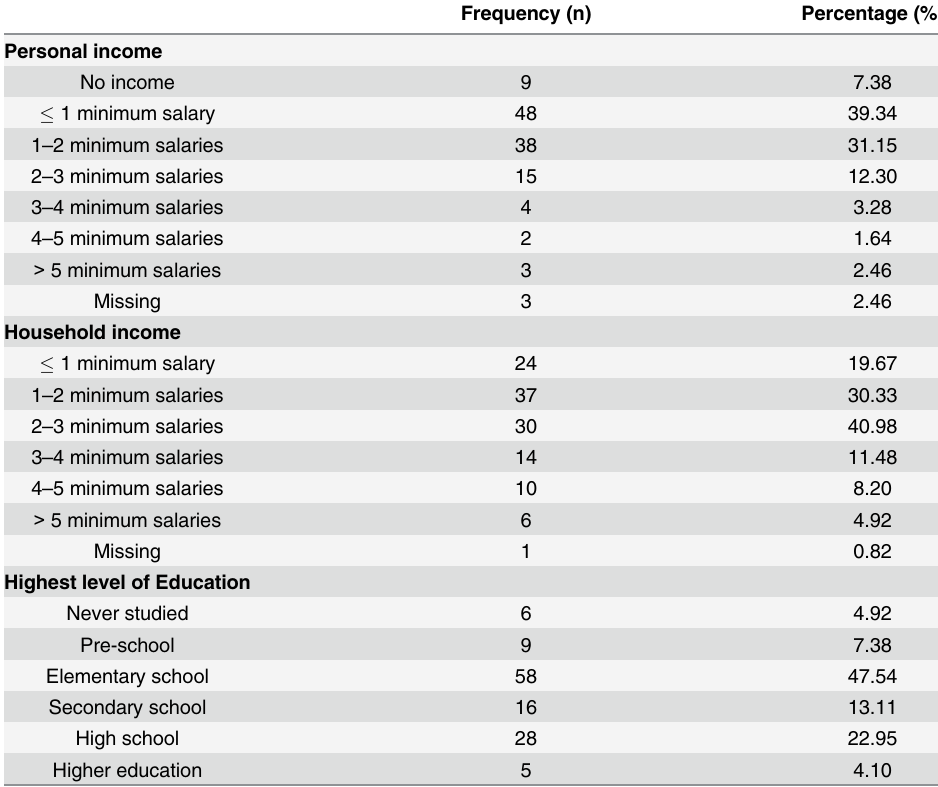
Frequency (n) Percentage (%)